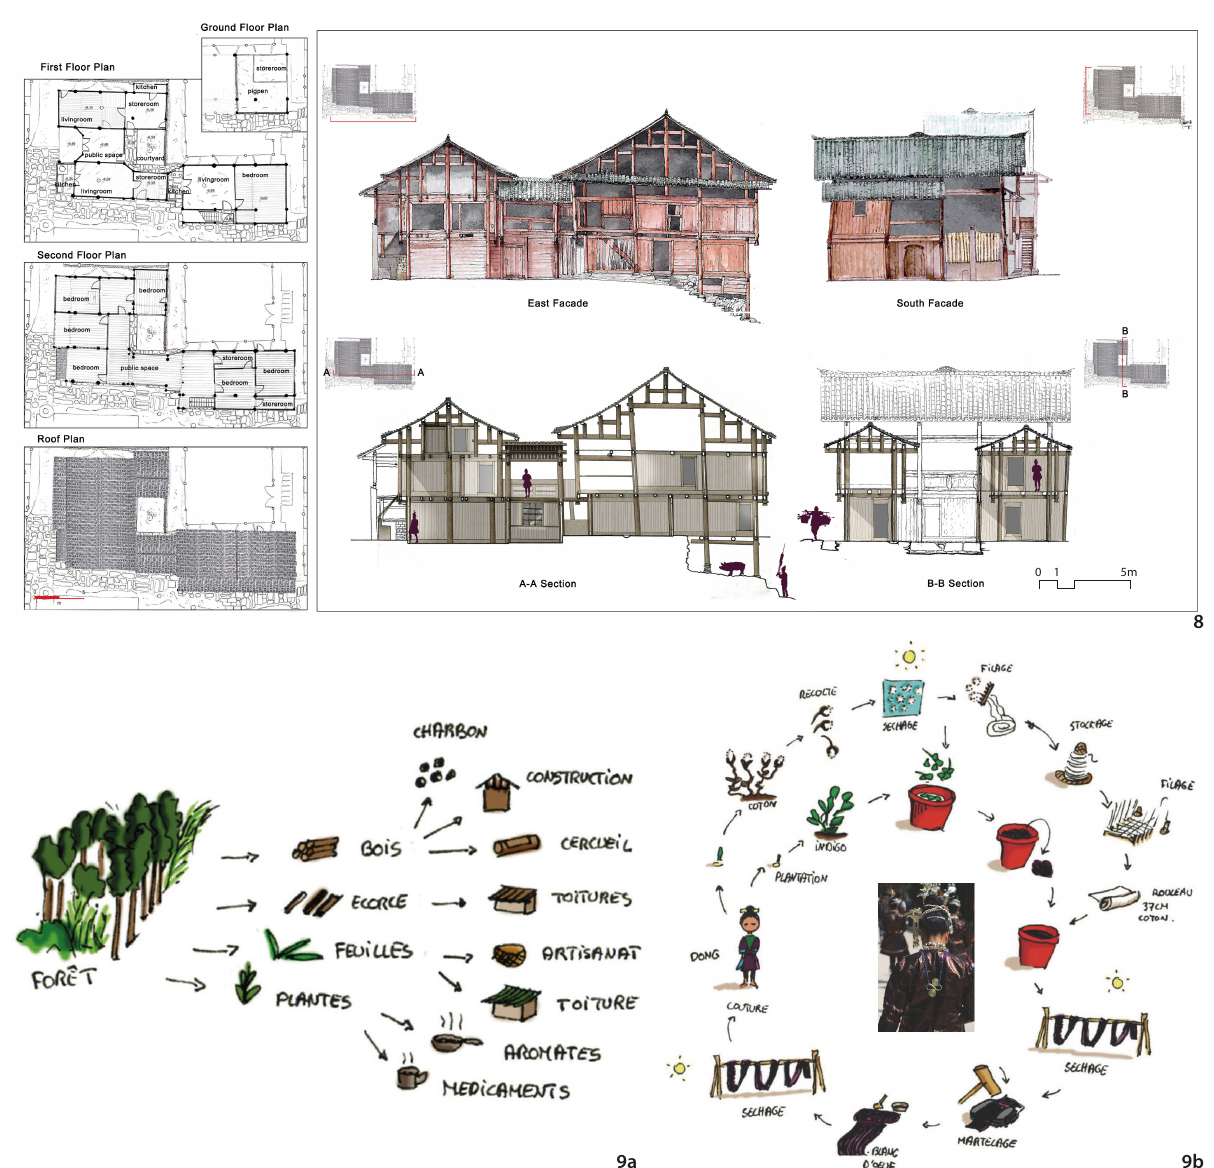
Figure 8 The typical residential house in Zengchong (Source: outcome of Zengchong Chinese-French Workshop). Figure 9a and 9b Traditional handicrafts transformed natural resources into all kinds of goods necessary for the daily life (Source: outcome of Zengchong Chinese-French workshop)